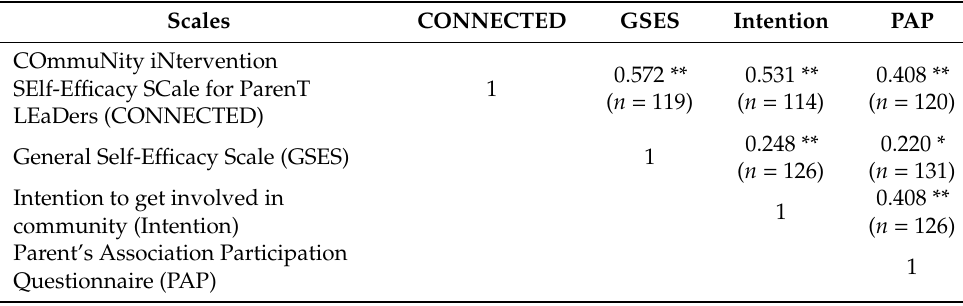
Table 4. Convergent validity: Spearman correlation and n